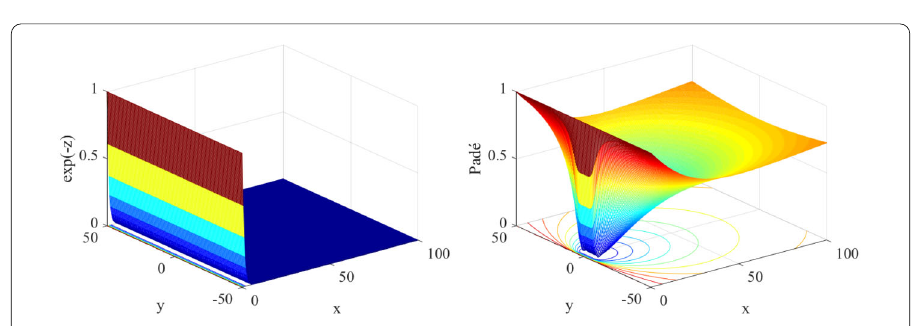
Figure 3 The behavior of Padé approximation with the complex plane z = x + iy ∈ [0,100] ×